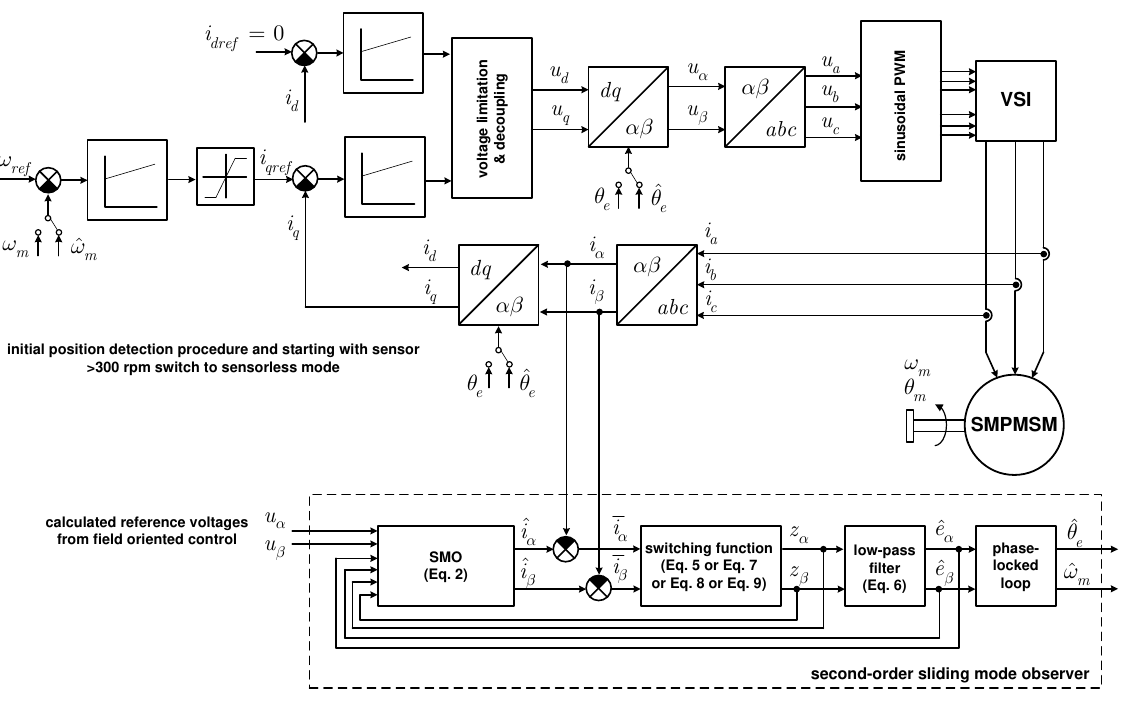
Figure 1. A block diagram of sensorless field oriented control with SOSMO and